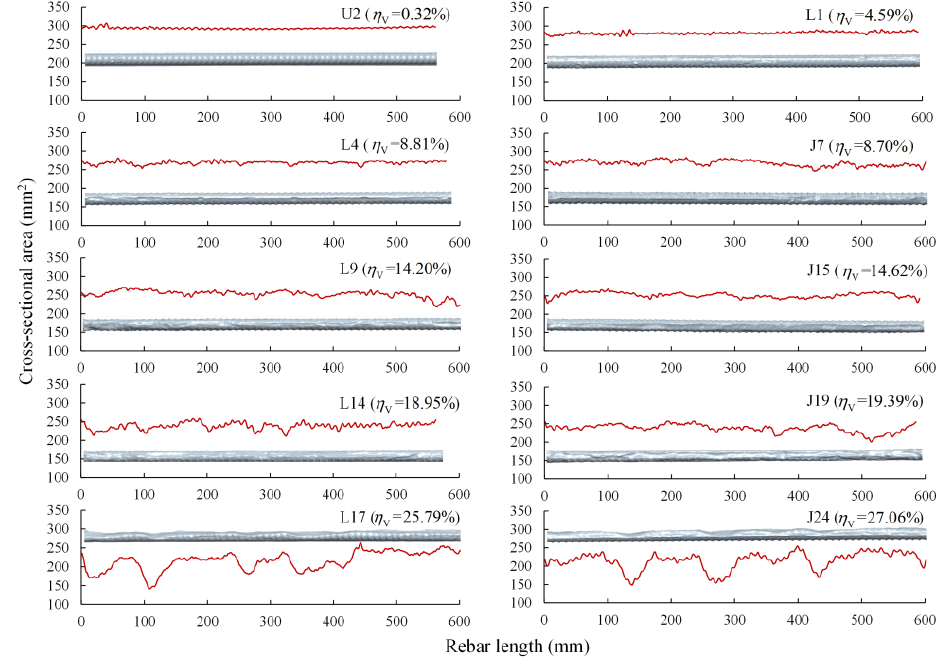
Figure 5. Residual cross-sectional areas along the length of rebar and rebar 3D solid models.